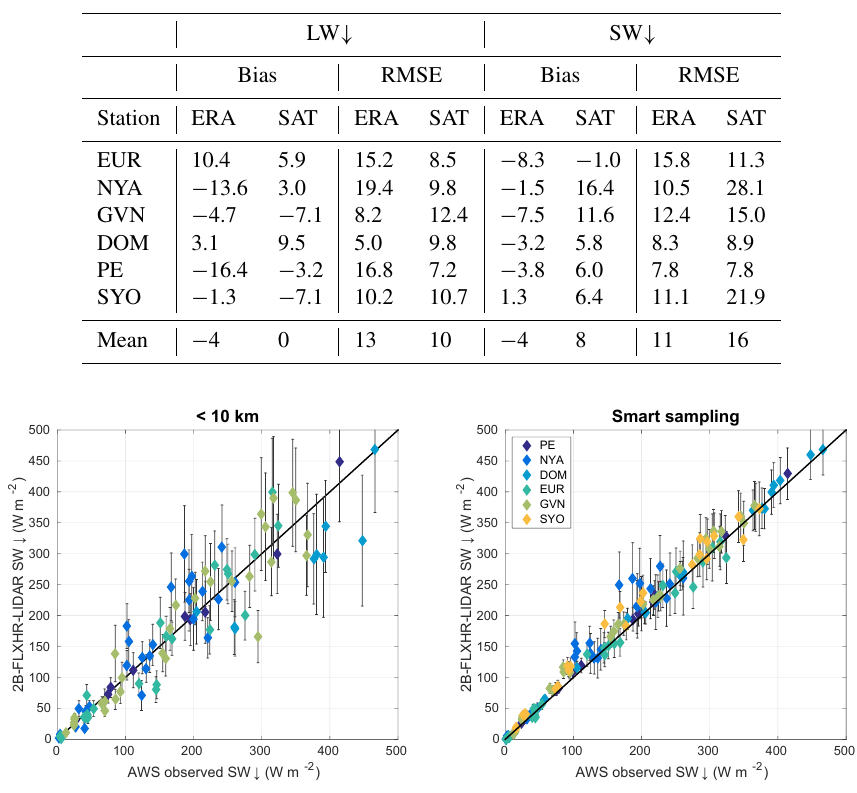
Table 6. Statistical comparison of ERA-Interim reanalyses (ERA) and CloudSat- and CALIPSO-retrieved surface radiative fluxes (2007– 2010) using the smart sampling approach (SAT) in terms of bias and RMSE against ground-based AWS observations. Note that the number of samples differs between the different data sources, since ERA-Interim radiative flux data are available at 6-hourly resolution, while satellite observations are constrained by the number of overpasses.